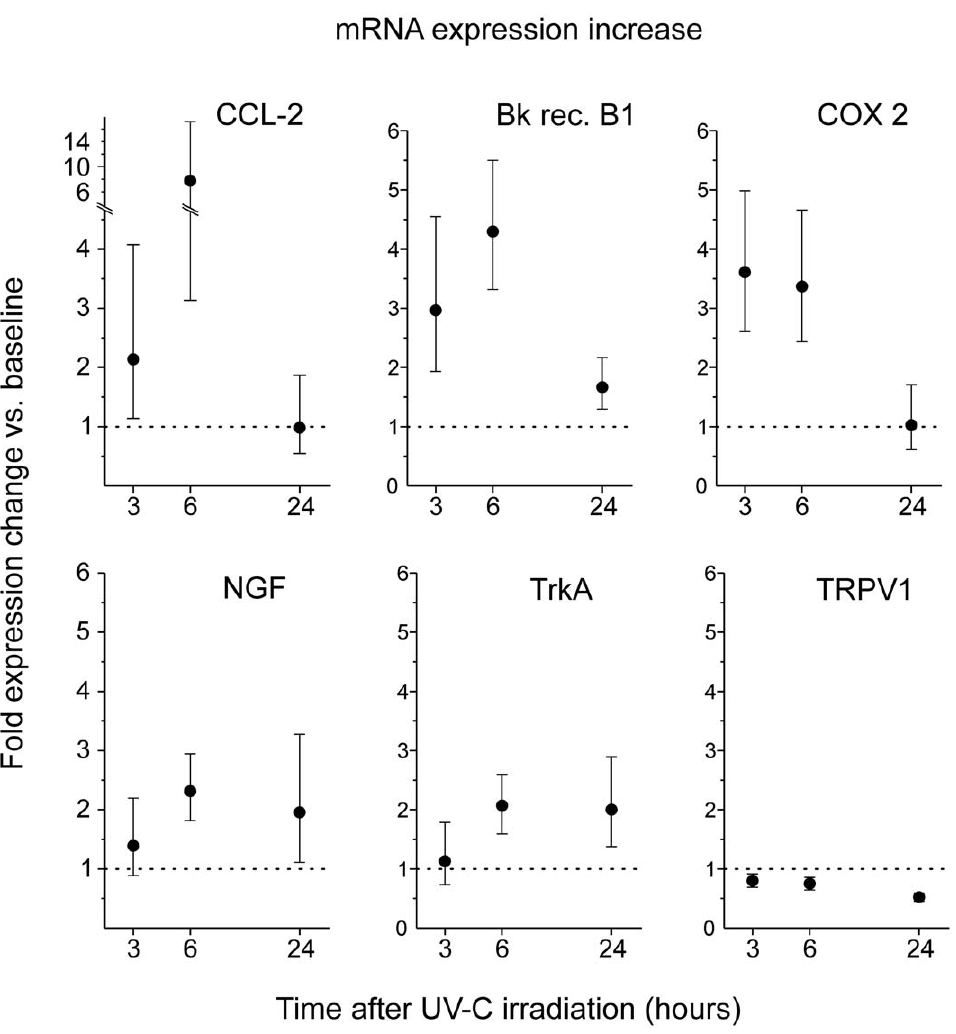
Figure 3. Group analysis of mRNA expression increase (RT-PCR, n=14). Changes upon UV-C irradiation are depicted as fold increase above baseline (dashed horizontal line represents no change) assessed at 3, 6 and 24 h post irradiation. Error bars indicate the 95% confidence